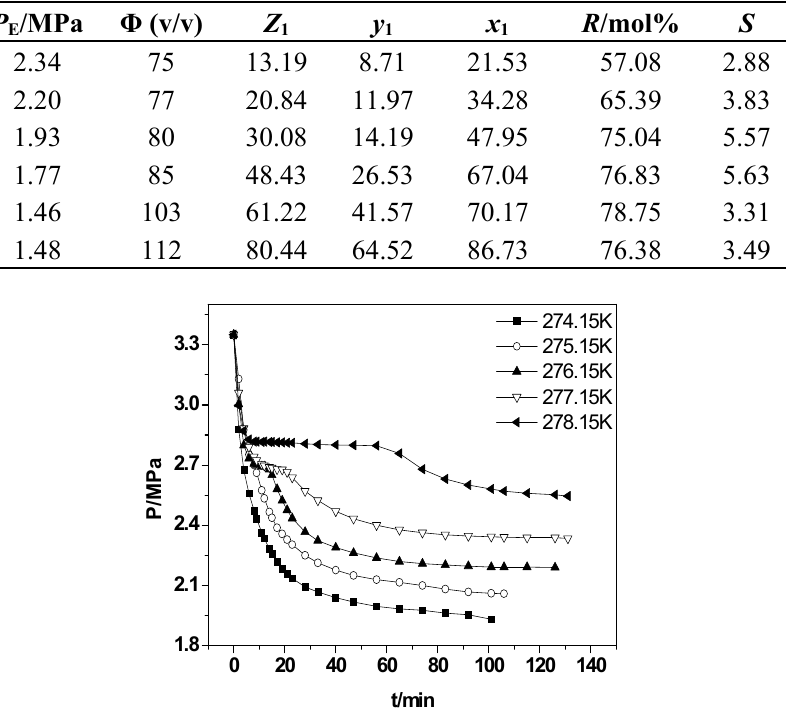
Figure 1. Kinetic curves of C 2 H 4 /CH 4 (30.08/69.92 mol%) mixture separation in W/O emulsion at fixed initial pressure 3.4 MPa but different temperatures.